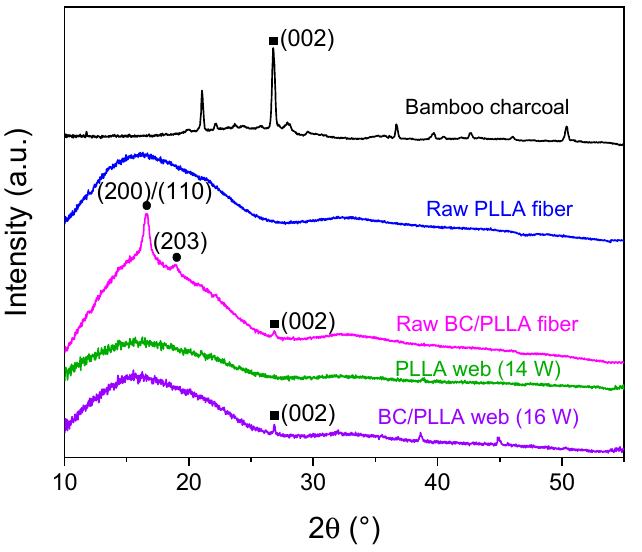
Figure 11. X-ray diffraction profiles of BC, raw PLLA and BC/PLLA fibers, and electrospun PLLA (14 W) and BC/PLLA (16 W) webs.